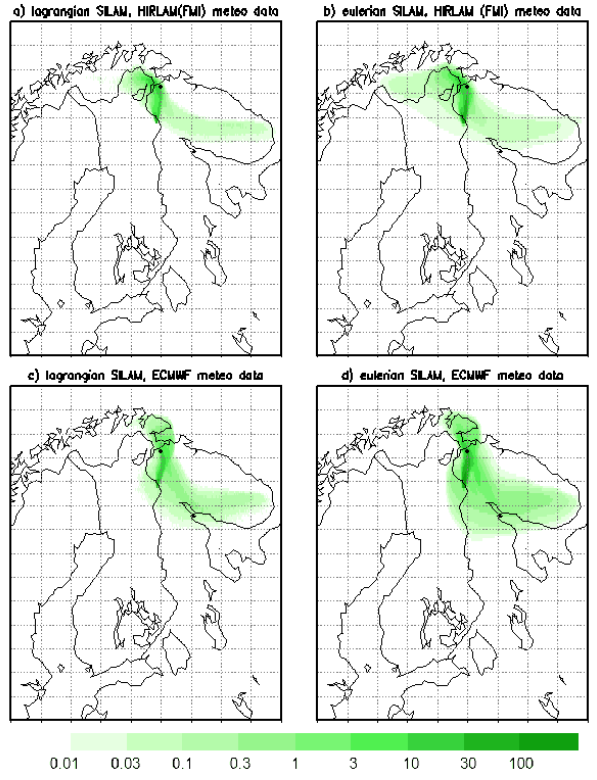
Fig. 6. A footprint of the highest peak of PM 2 . 5 concentration Figure 6. A footprint of the highest peak of PM2.5 concentration 2-3 May, 2003. Panels: a) 2–3 May 2003. Panels: (a) Lagrangian SILAM, HIRLAM me- Lagrangian SILAM, HIRLAM meteo, b) Eulerian SILAM, HIRLAM meteo, c) Lagrangian teo, (b) Eulerian SILAM, HIRLAM meteo, (c) Lagrangian SILAM, SILAM, ECMWF meteo, d) Eulerian SILAM, ECMWF meteo. Location of the Nikel plant is ECMWF meteo, (d) Eulerian SILAM, ECMWF meteo. Location of marked by a dot. the Nikel plant is marked by a dot.